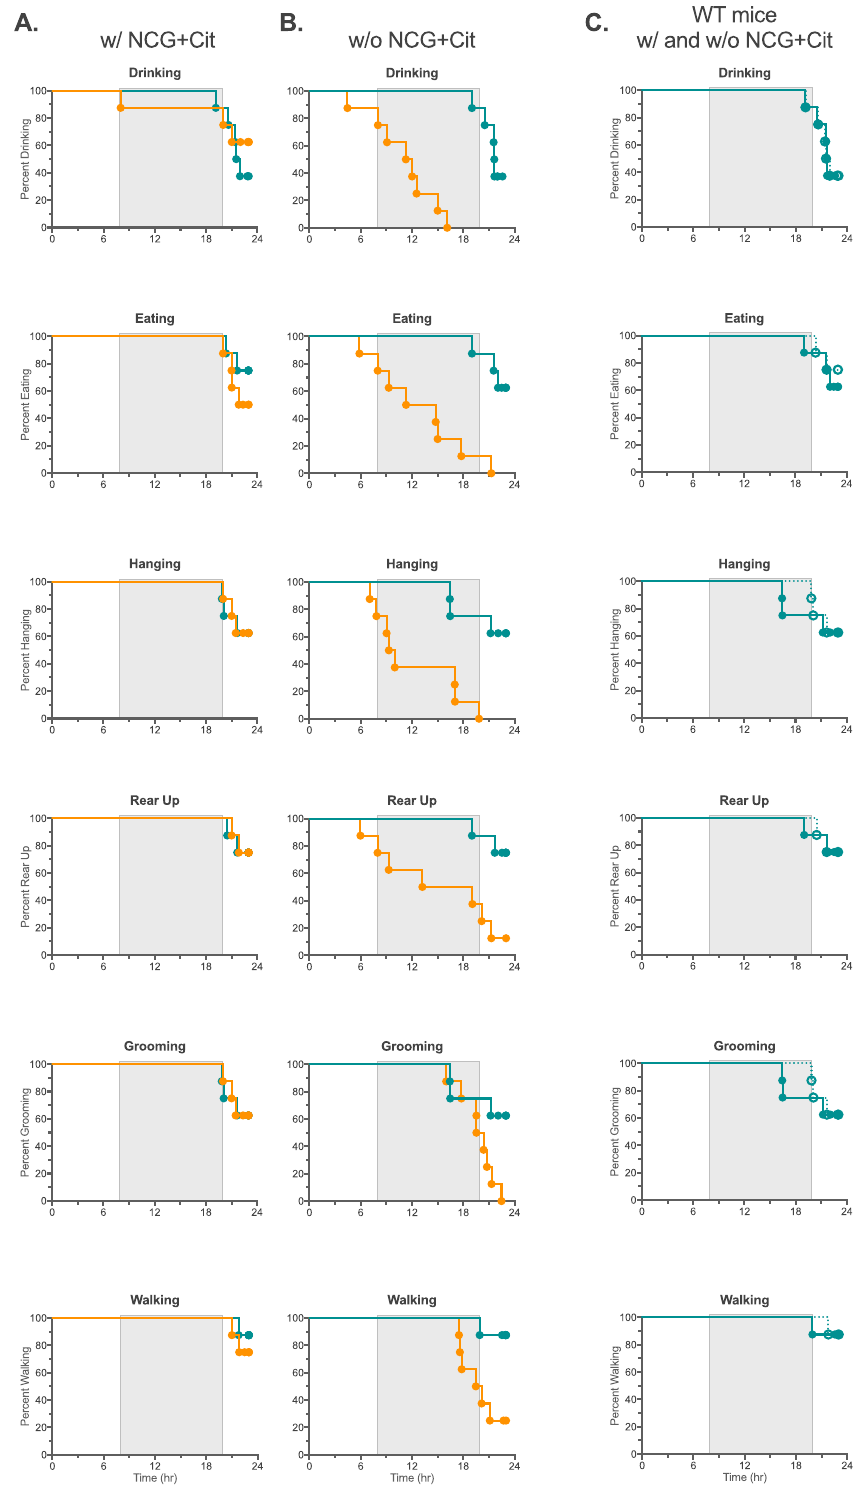
Figure 2. Different behaviors of the Nags −/− (orange) and Nags + / + (teal) mice with respect to cessation of drinking, eating, hanging, rearing up, grooming, and walking ( A ) during 24 h before withdrawal of NCG + Cit supplementation and ( B ) in the 24 h period after withdrawal of NCG + Cit supplementation at 10 AM. The same results are shown in ( C ) for wild-type mice before (solid) and after (hatched) withdrawal of NCG + Cit supplementation. Shaded rectangles indicate the period of darkness between 6 PM and 6